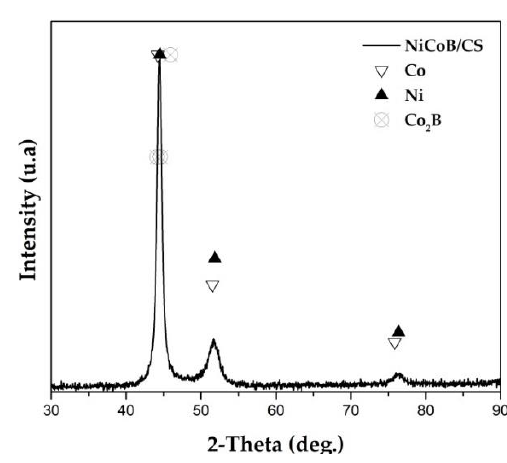
/ CS coating obtained from a plaque type Figure 2. X-ray spectrum of the NiCoB/CS coating obtained from a plaque type sample. Figure 2. X-ray spectrum of the NiCoB